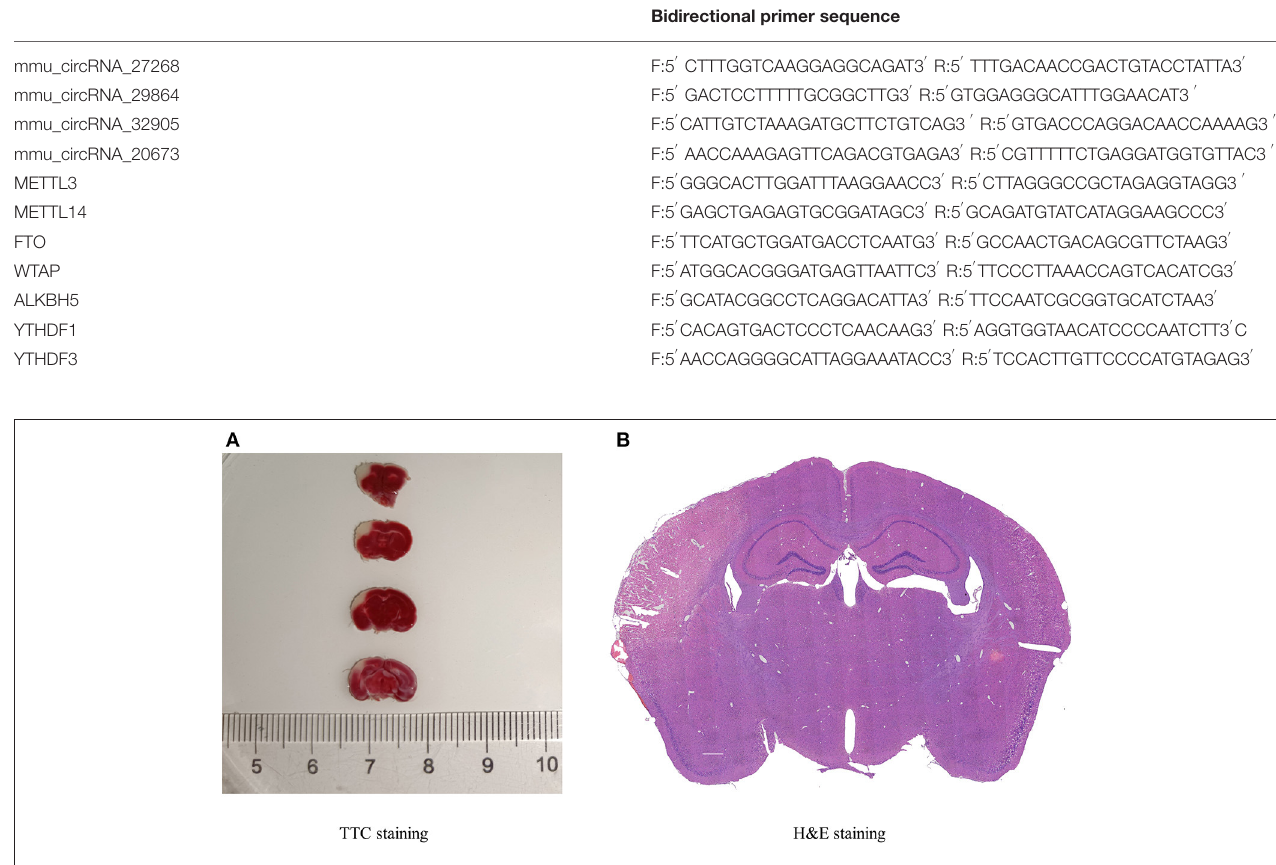
FIGURE 1 | Histopathology of cerebral infarction. (A) TTC staining displayed the infarcted areas in white, and the normal areas in red, ( n = 3). (B) H&E staining presented the destruction of morphology in the infarct lateral cortex compared with the Contralateral cortex ( n =